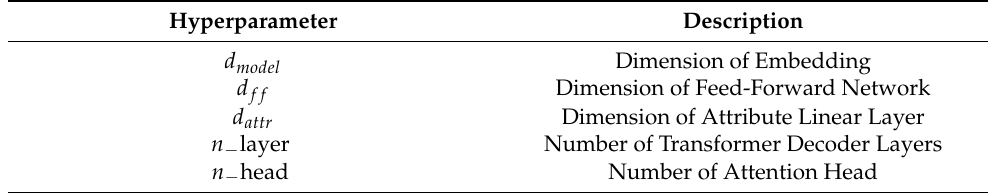
Table 5. Description of hyperparameter.